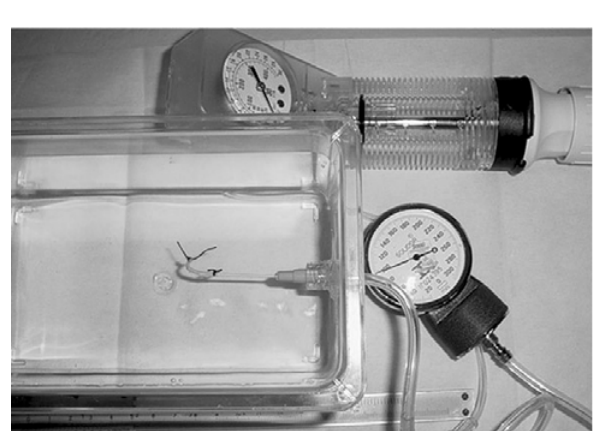
Fig. 4 - Amostra arterial demonstrando a avaliação da pressão de ruptura